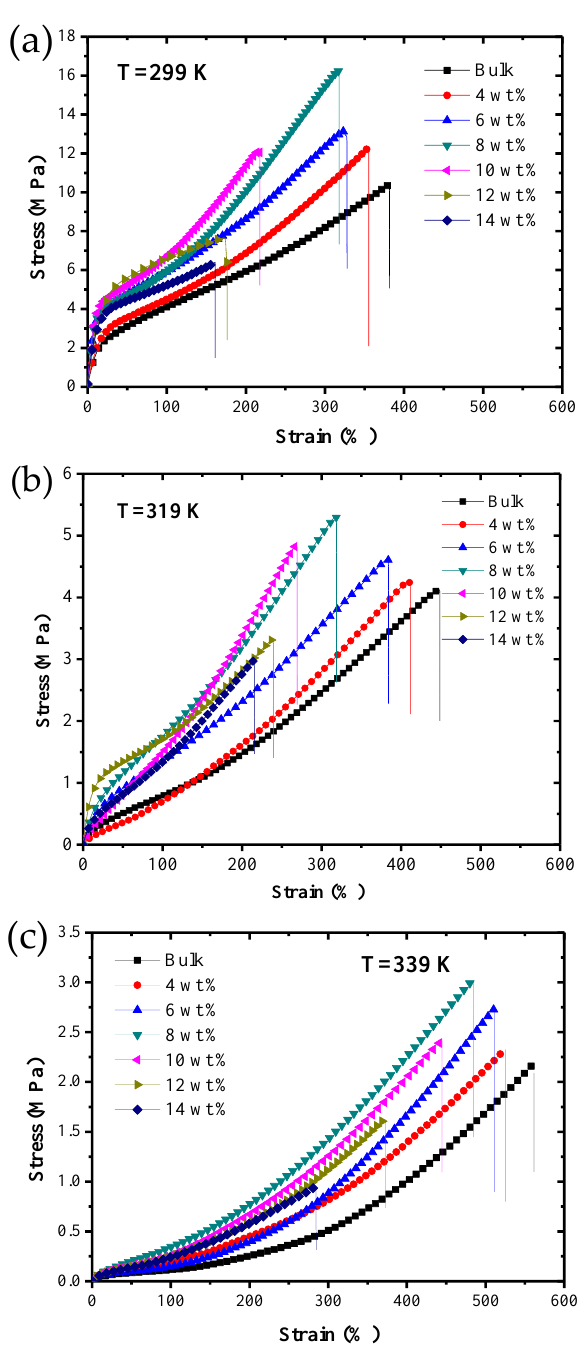
Figure 7. The static tensile stress–strain curves of shape memory polymer composite specimens with different chopped carbon fiber contents at three test temperatures: ( a ) 299 K, ( b ) 319 K and ( c ) 339 K.